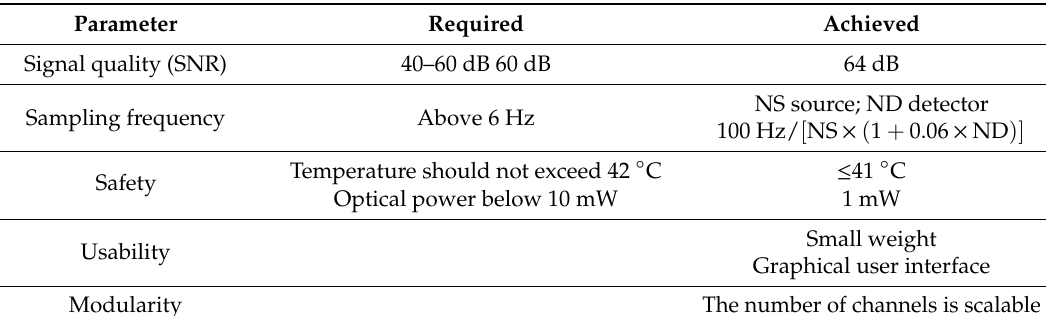
Table 2. Main CW required and achieved parameters [40].